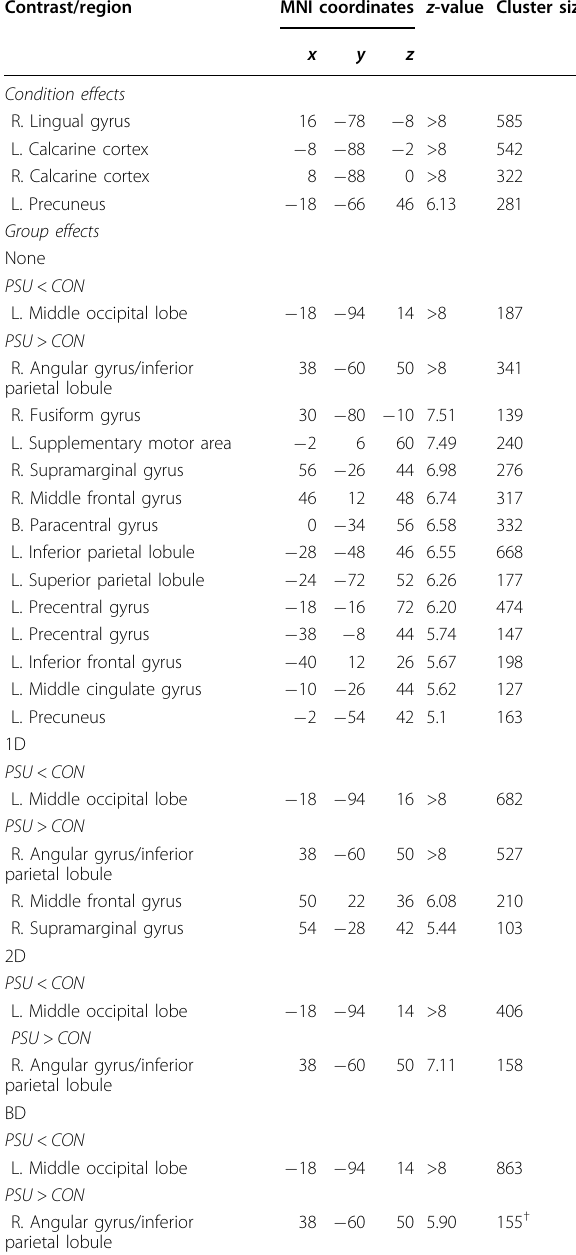
Abbreviations: B bilateral, CON control, L left, PSU problematic smartphone user, R